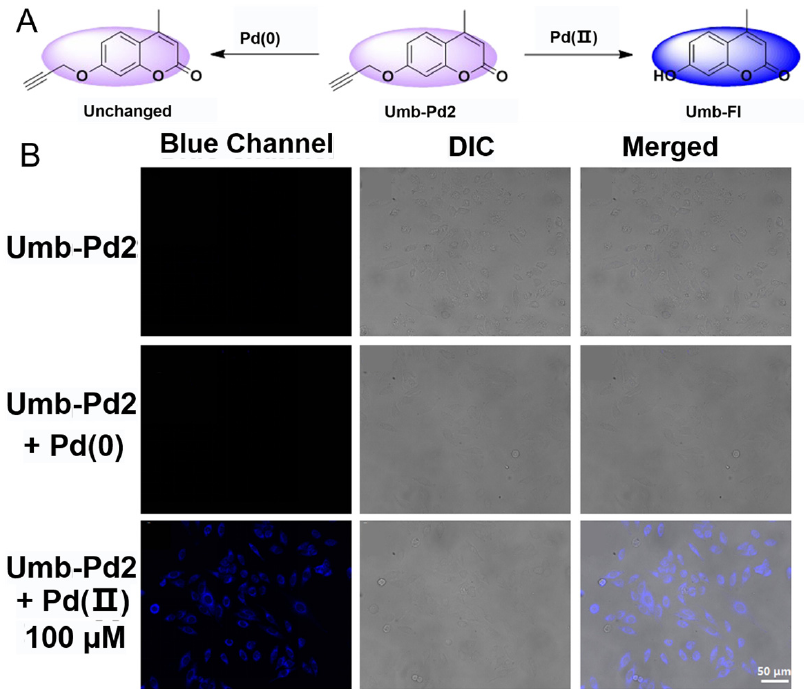
Figure 10. ( A ) Schematic illustration of the selective detection for Pd (II) by Umb-Pd2. ( B ) The confocal images of HeLa cells incubated with Umb-Pd2 in different conditions. Reproduced from [149] with permission from Elsevier, copyright 2019.